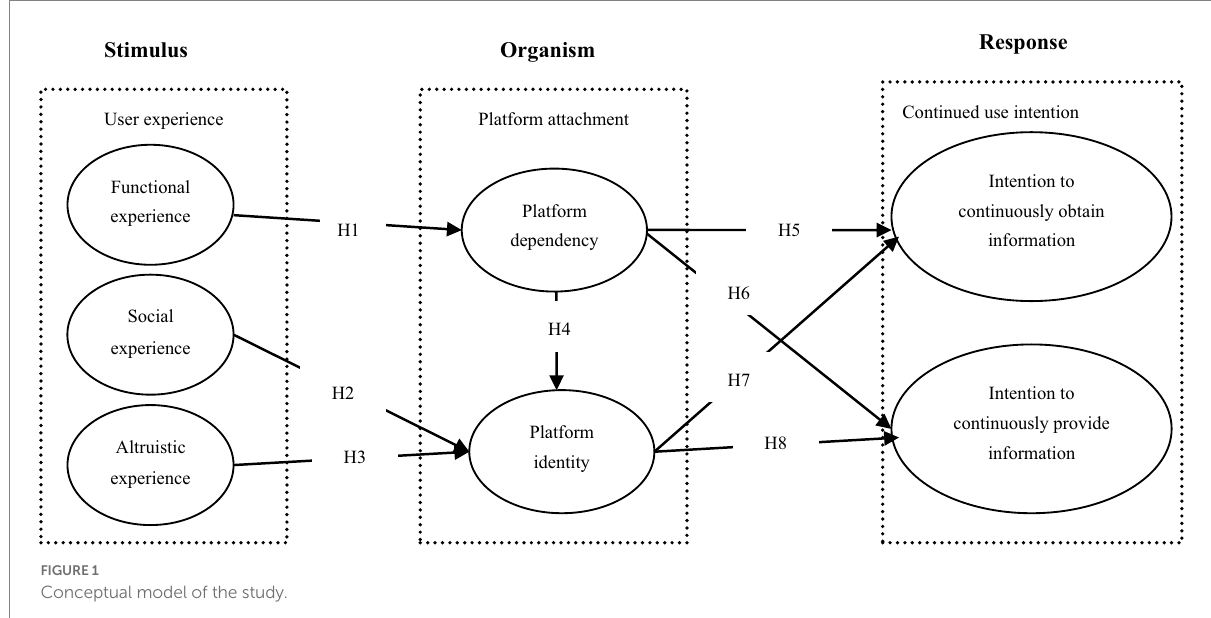
FIGURE 1 Conceptual model of the